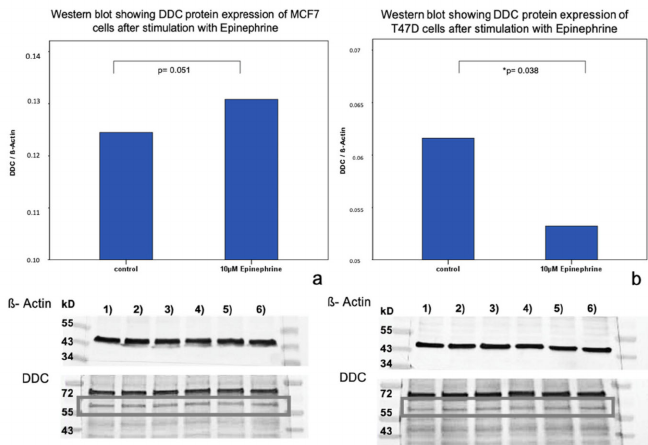
Figure 4. Western Blot analysis of DDC protein expression in MCF7 and T47D cells after stimulation with epinephrine. ( a ) Bar chart of DDC expression in MCF7 cells after incubation with 10 µ M epinephrine. Epinephrine led to an increase of DDC protein expression ( p = 0.051) that was not significant. 1)–6) Western blot membranes after incubation with ß-actin and DDC antibodies (marked with gray box). 1) 3) 5): control samples. 2) 4) 6): stimulated samples with 10 µ M epinephrine. ( b ) Bar chart